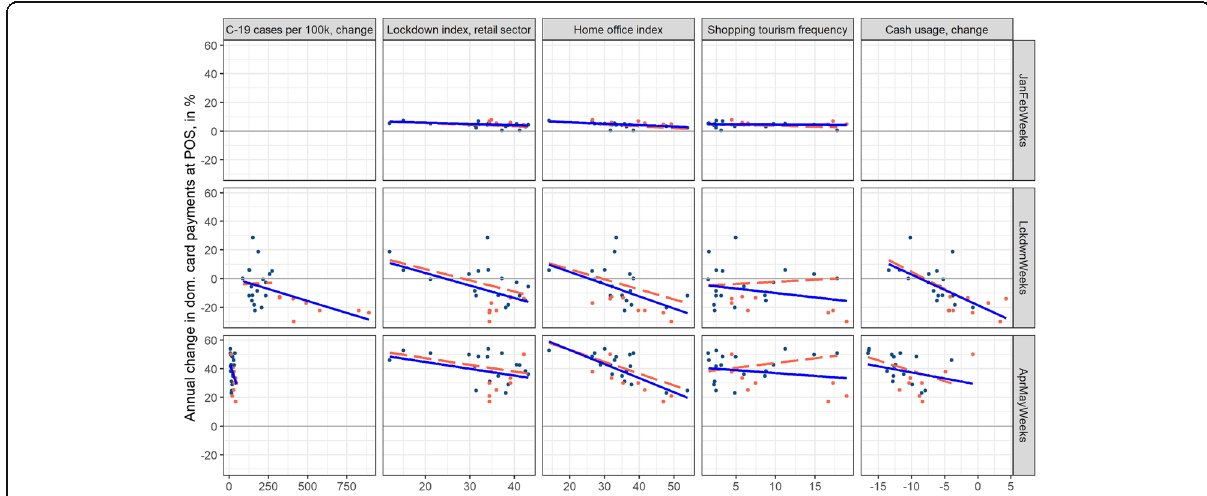
Fig. 9 Excess domestic card-present retail payments versus further sources of shifts per canton for pre-lockdown (upper panel), lockdown (middle panel), and post-lockdown periods (lower panel). Source: Own calculations, Worldline/SPS,